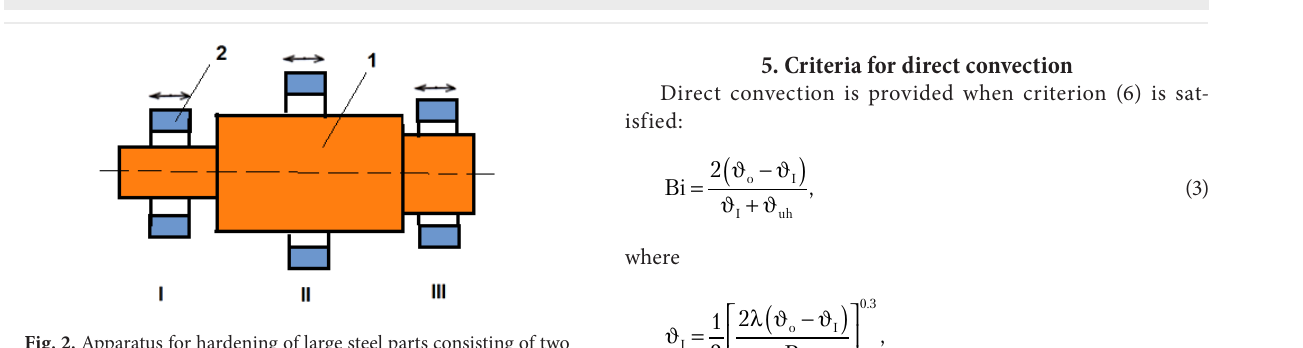
Fig. 2. Apparatus for hardening of large steel parts consisting of two sectioned sprayer moving periodically along the axis in area I, II, and III: 1 is spryer; 2 is rotor [1]